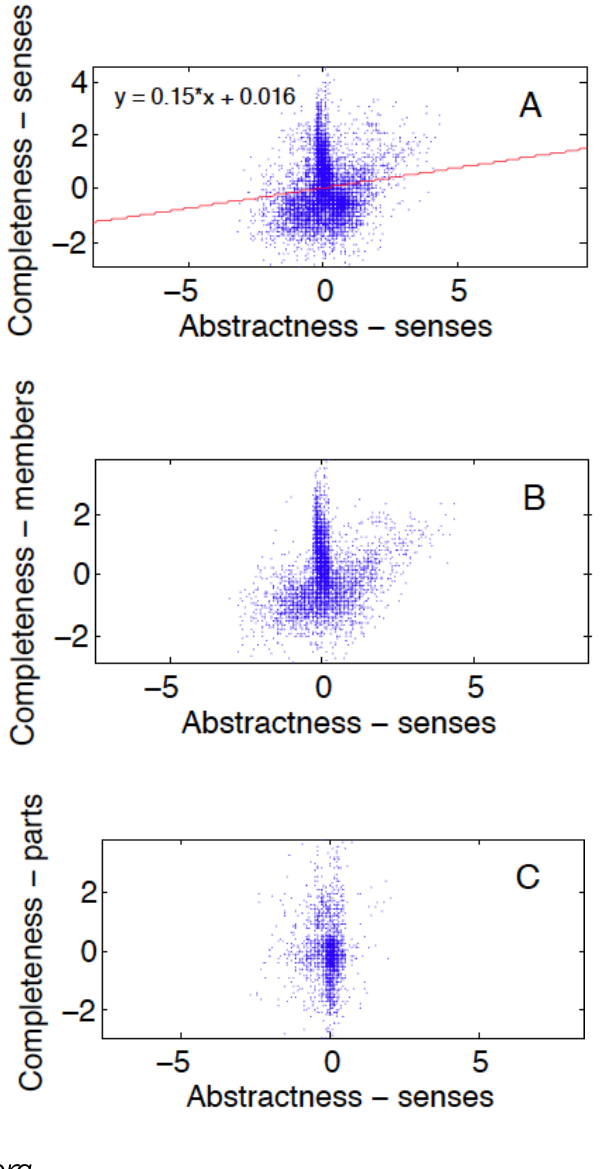
Figure 7. ( A ) Abstractness and completeness dimensions are linearly independent semantic dimensions, with the Pearson correlation R = 0.113; ( B , C ) Memberonymy and partonymy